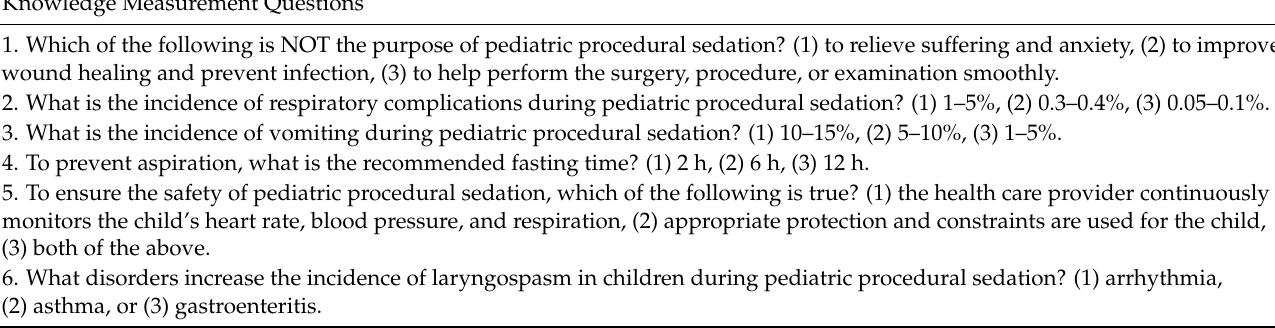
Table A1. Knowledge measurement and satisfaction